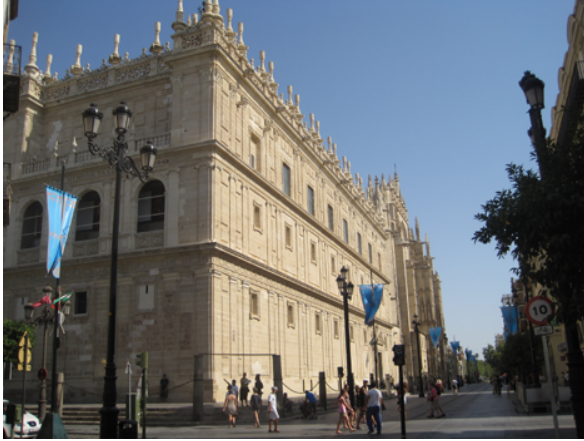
Figure 1: Exterior view of the church of the Sagrario, Seville Cathedral. Photo by